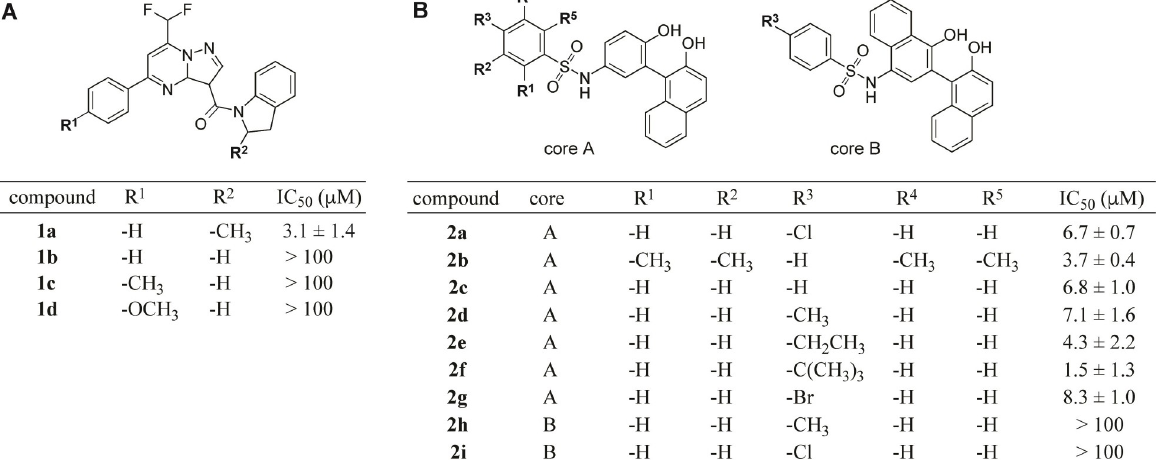
Fig 4. Structure activity relationship of select ENTPD5 inhibitors identified by HTS. Close analogs of hits 1a (A) and 2a (B) were assayed with B.ENTPD5 to assess the effect of conservative substitutions to the scaffolds. Compounds were assayed at 5, 10, 20, and 40 μ M using the coupled enzyme HTS assay to determine IC 50 values. Data were fit by nonlinear regression.